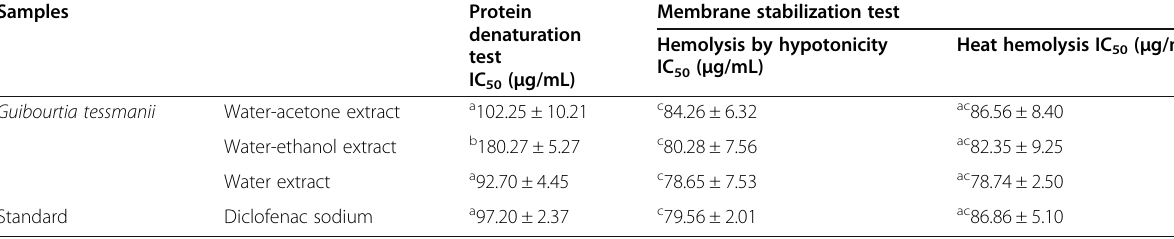
Table 2 Anti-inflammatory activity of Guibourtia tessmanii J. Léonard extracts Samples